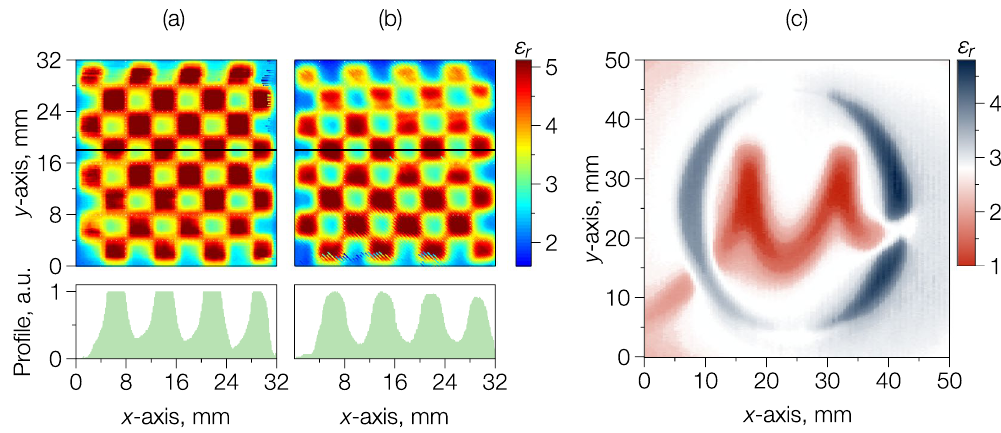
Figure 4. The spatial distribution of the relative dielectric permittivity in a 3D-printed chessboard with alternating cells of ε 1 = 2.6 and ε 2 = 5.2, using an SRR probe with w × g = 1.9 × 0.3 mm 2 gap oriented ( a ) normal to the vertical cell boundaries and ( b ) at 45° to the cell boundaries (the bottom insets show the profiles along the black horizontal lines in the maps); ( c ) the relative dielectric permittivity map of a 3D-printed logotype of the Oxford Materials composed of “three-colour” materials with ε 1 = 2.6, ε 2 = 5.0 and ε 3 = 1.